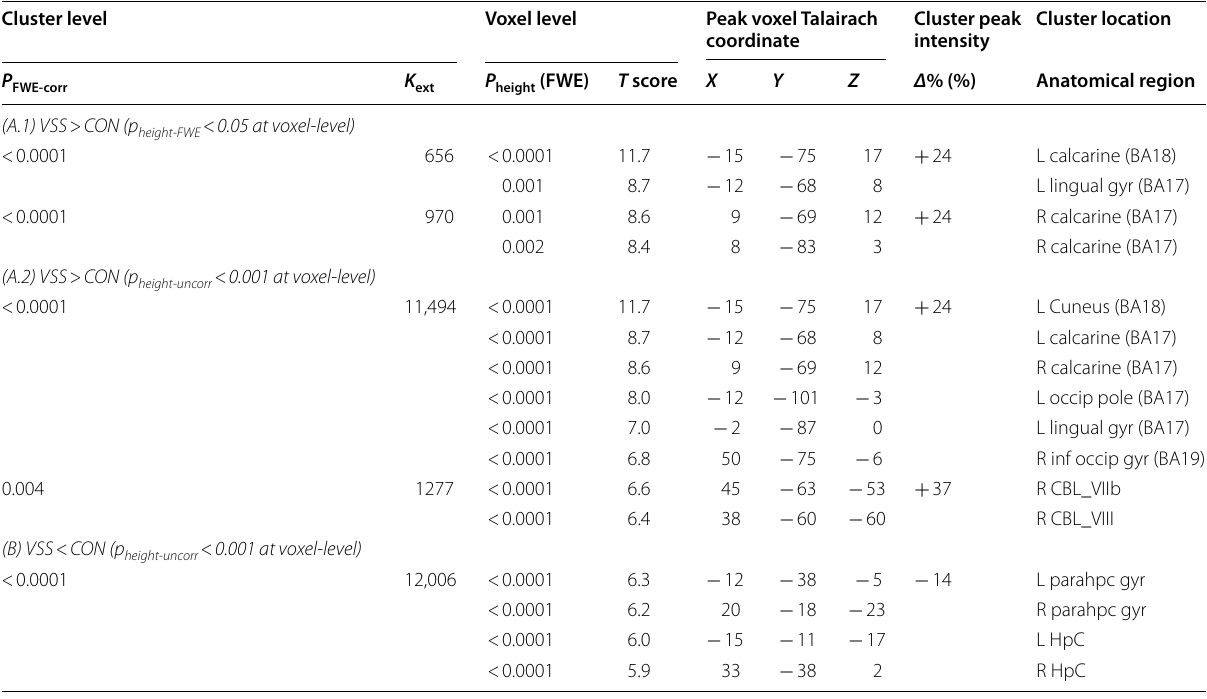
Table 2 Results of the voxel-based group comparison (SPM12) showing the significant glucose metabolism differences in visual snow syndrome (VSS) patients compared to healthy controls (CON)